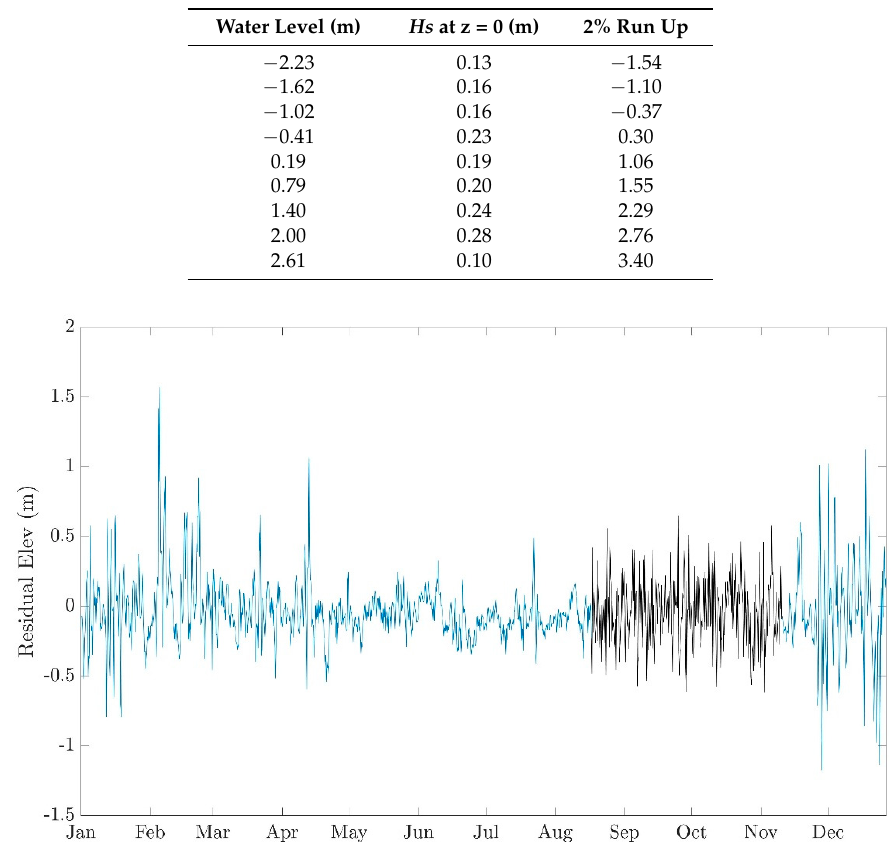
Figure A2. Offshore residual surge elevation time series. The elevation data are from the Cromer tide gauge station and referred to m above Newlyn datum. The data gap on the Elevation data is shown on the residual elevation plot as black line.